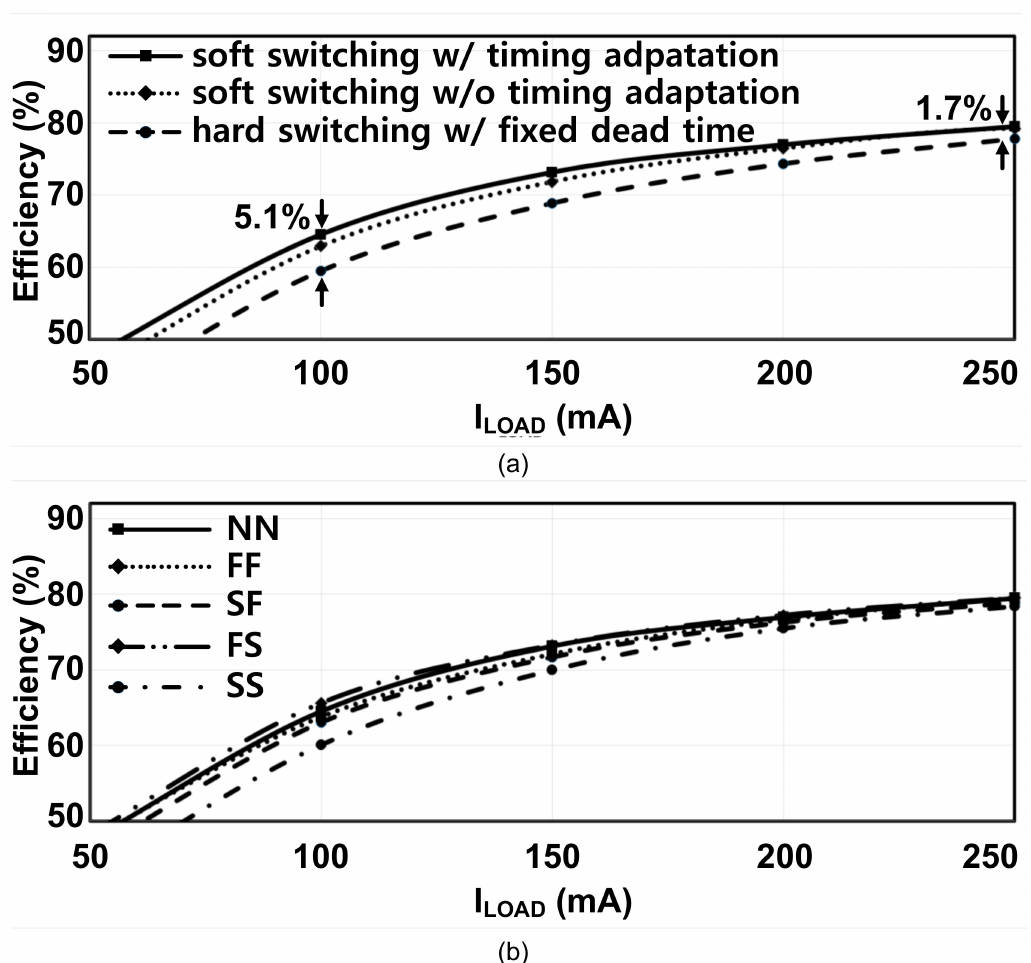
Figure 10. Power-conversion e ffi ciency ( a ) according to the output current and ( b ) process corners at V IN = 2.4 V and V OU T = 1.0